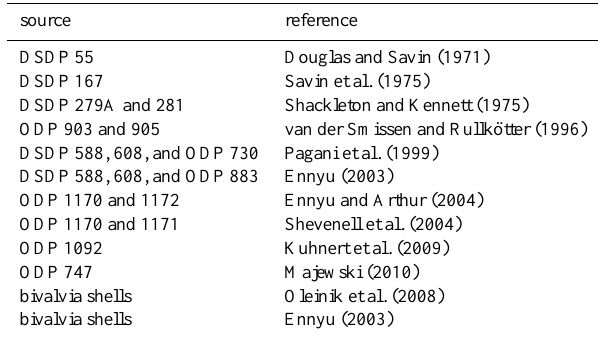
Fig. 13. Surface salinity for all experiments as contours (in psu). Overlaid as arrows is the vertically integrated moisture transport according to Eq. (4) (in kg/(ms)). Table 4. References of marine proxy SST